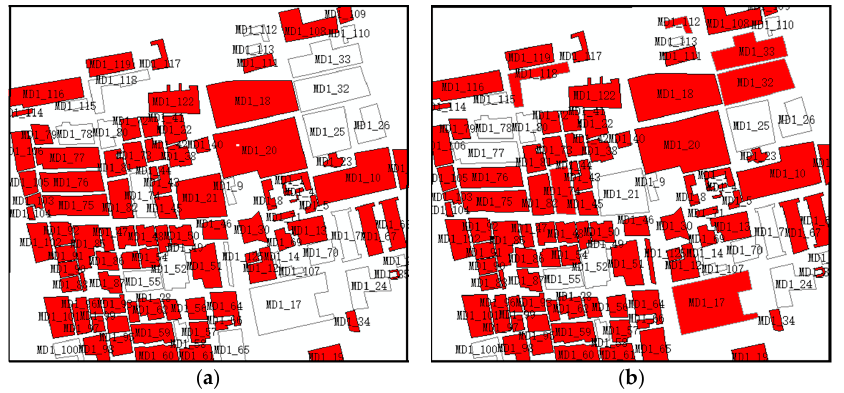
Figure 4. Illustration of hierarchical matching result ( a ) and weighted matching result ( b ), respectively (the highlighted represents matched objects). Table 2. Comparison of experimental results from study